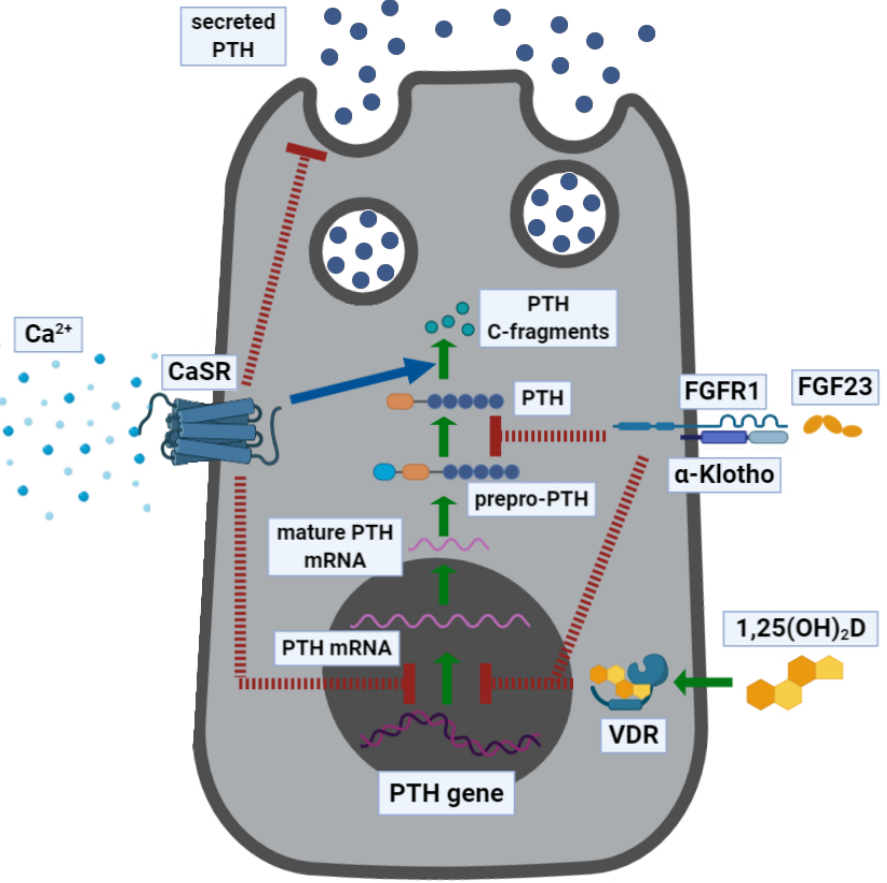
Figure 1. Parathyroid hormone expression and secretion in parathyroid cells. Parathyroid hormone (PTH) is expressed as a prepro-PTH that is then cleaved into mature PTH and stored in granules until secreted. PTH mRNA transcription and PTH secretion are inhibited following the activation of the calcium-sensing receptor (CASR) by extracellular calcium [Ca 2 + ] e , which also stimulates the intracellular inactivation of PTH, into biologically inactive C-terminal fragments, operated throughout the cleavage. Osteocyte-derived fibroblast growth factor (FGF)-23 activates the FGF receptor (FGFR1), heterodimerized with its coreceptor α -Klotho, and inhibits PTH mRNA transcription and PTH protein maturation from prepro-PTH. Finally, 1 α ,25-dihydroxyvitamin D (1 α ,25-(OH) 2 D) binds the intracellular vitamin D receptor (VDR) and inhibits the expression of PTH mRNA. The green arrows indicate PTH expression, the blue arrow indicates a stimulatory pathway, and the red dashed lines indicate inhibitory pathways. PTH binds through its N-terminal domain a specific class II G-protein coupled receptor (GPCR) expressed by the target tissues, the PTH/PTHrP (PTH related peptide) receptor type 1 (PTHR1) [20,21]. PTHR1 is also targeted by PTHrP, a peptide sharing homology with the N-terminal portion of PTH. Unlike PTH, PTHrP explicates its action in an autocrine/paracrine fashion. Based on PTHR1